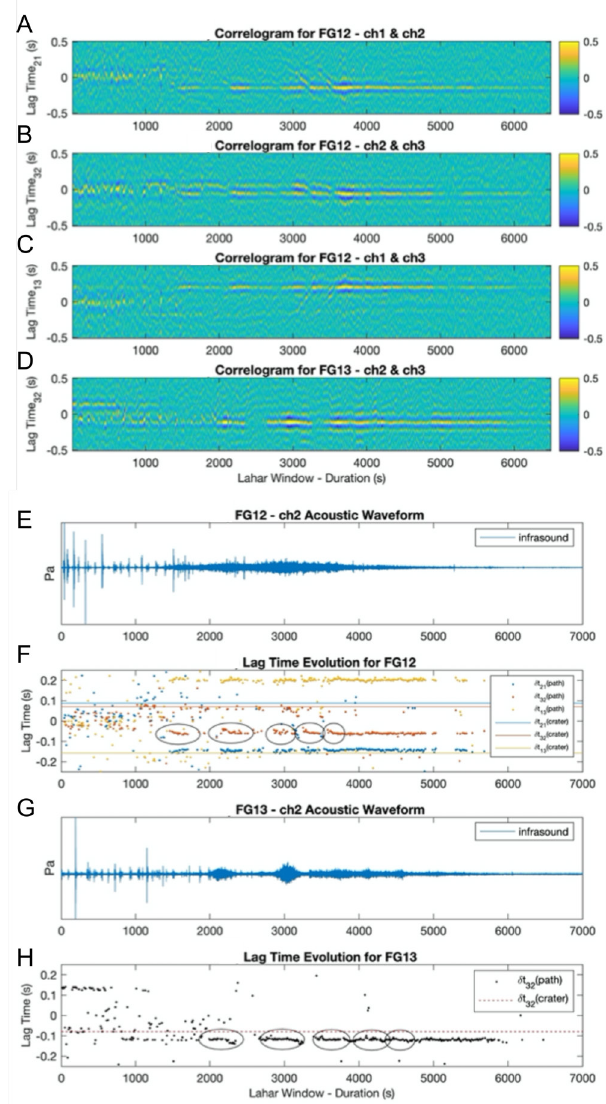
Figure 6: [A–D] Correlograms using the calculated RMS values suggest a sound source flowing from up- stream to downstream. “Hotspots” (i.e. yellow) rep- resent highly correlated signal data. [E–H] Channel 2 infrasound waveforms for both stations and cross- correlation lag time chronologies for all channel pairs within each array for the confined lahar timing window (~1420–5000 s for FG12 and ~2000–6000 s for FG13). Solid dots represent upsampled time lags from candi- date sound source, compared with time lags from a point-source, such as an eruption from the summit of Volcán de Fuego (dashed lines). At least 5 pulses can be observed in both plots (circled in [F] and [H]), with the first pulse appearing approximately ~1420 s at FG12, and ~2000 s at FG13 for panels